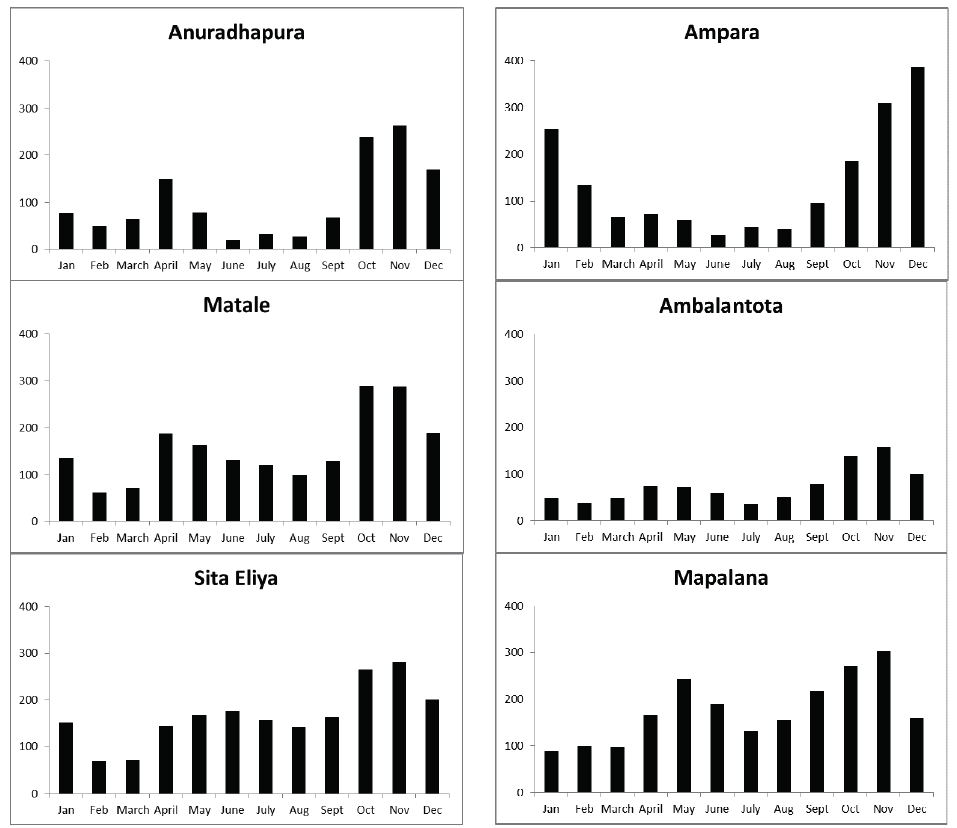
Figure 2. Average monthly rainfall totals (mm) for a selection of stations included in the